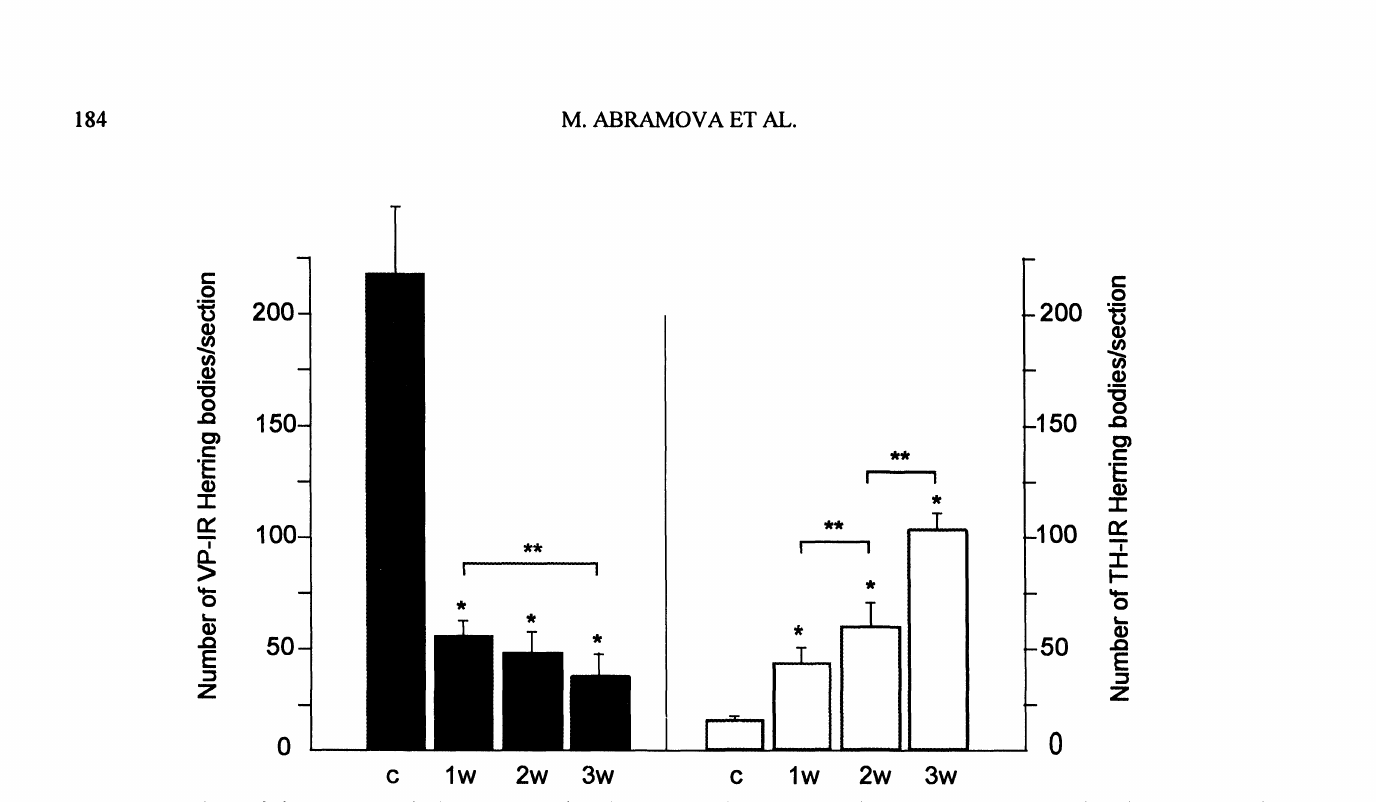
Fig. 2: Number of the vasopressin-immunoreactive (VP-IR) and tyrosine hydroxylase-immunoreactive (TH-IR) Herring bodies in the posterior lobe per section in control (intact) rats (c) and in rats salt-loaded (2% NaC1) for 1, 2 and 3 weeks (w). * P < 0.01, compared to the control. ** P < 0.01, comparison between selected groups.